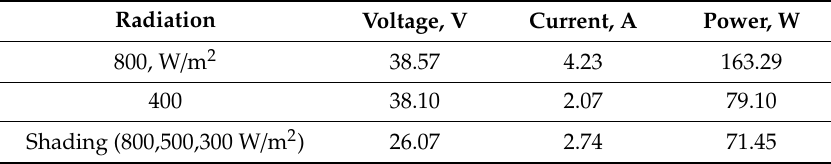
Table 3. Characteristics of PV panel under di ff erent